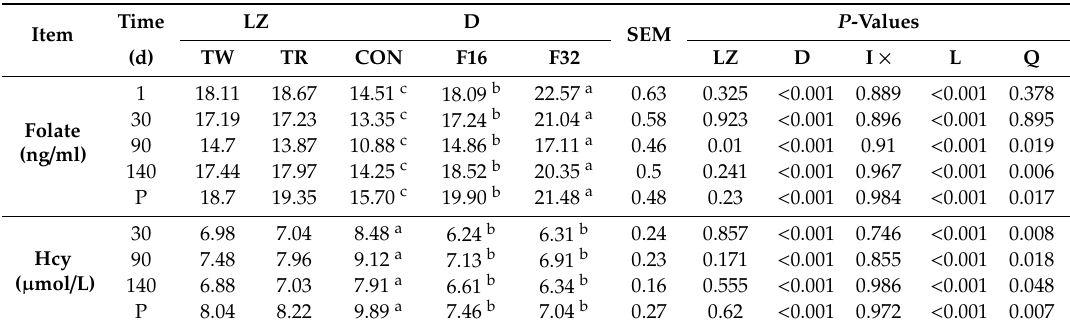
Table 2. Folate and Hcy concentrations in the serum from mating to parturition.